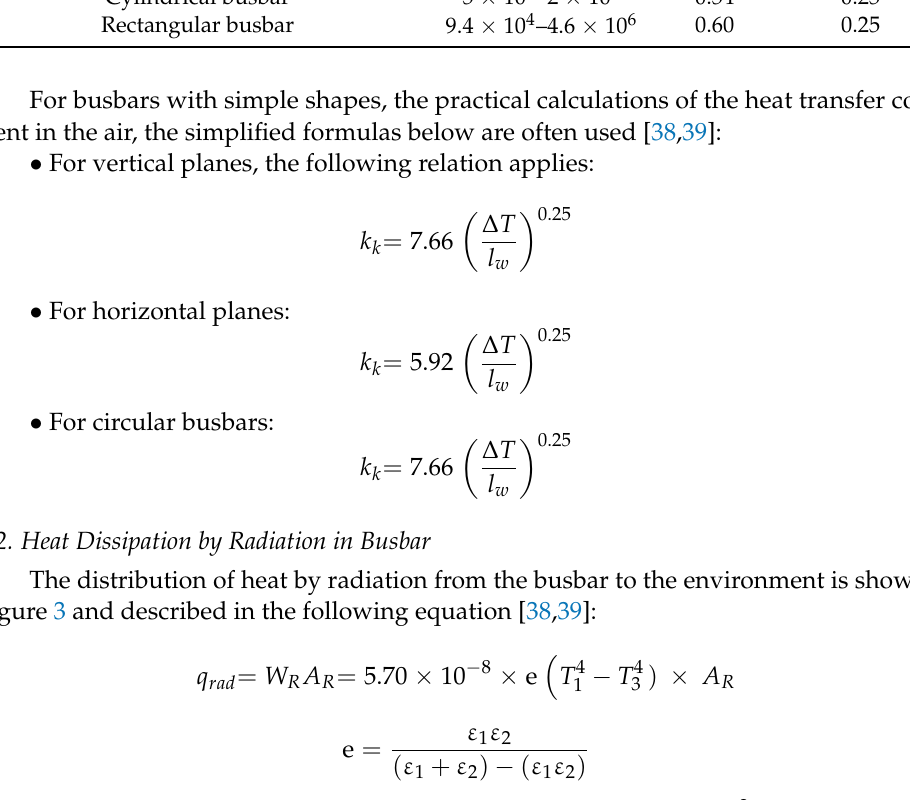
Table 1. The list of c 1 and n 1 values for a given Gr and Pr range. The Shape of the Cooled Element Gr · Pr c 1 n 1 Switchboard vertical